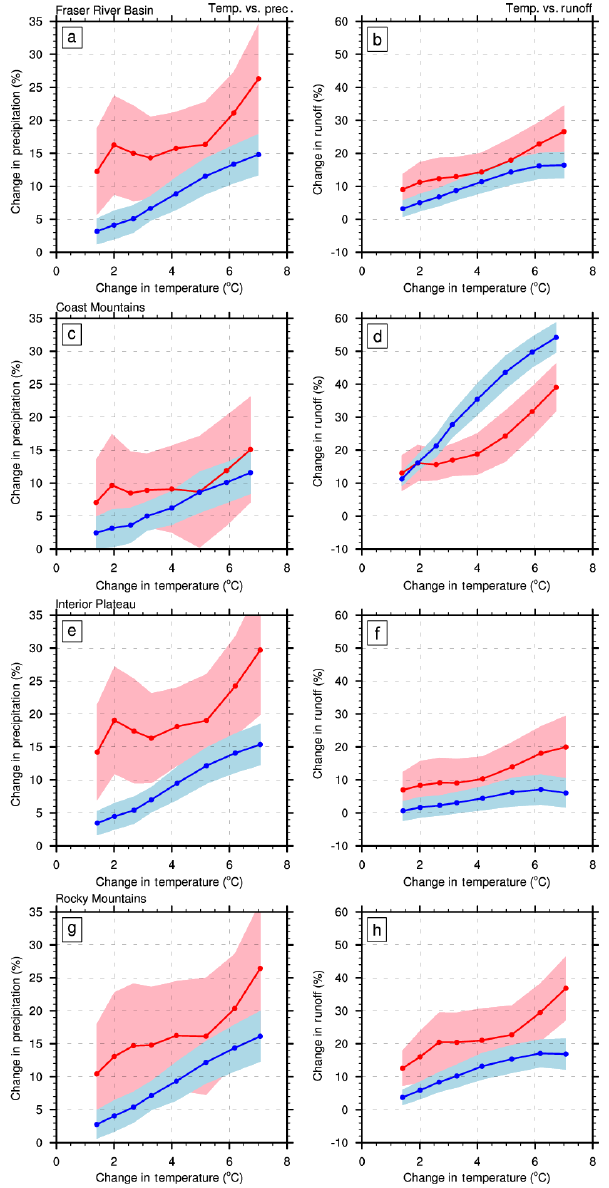
Figure 3. Rate of change of mean and interannual variability with warming for precipitation (a, c, e, g) and runoff (b, d, f, h) during the cold season. Changes in the cold season mean (blue line) and interannual standard deviation (red line) are shown as a function of cold season mean temperature change for the Fraser River Basin (a, b) , Coast Mountains (c, d) , Interior Plateau (e, f) and Rocky Moun- tains (g, h) . Each marker indicates a 30-year period centred on con- secutive decades between 2010 and 2080 relative to the base pe- riod of the 1990s. Shading represents inter-model spread in 30-year means, as indicated by a 5%–95% model